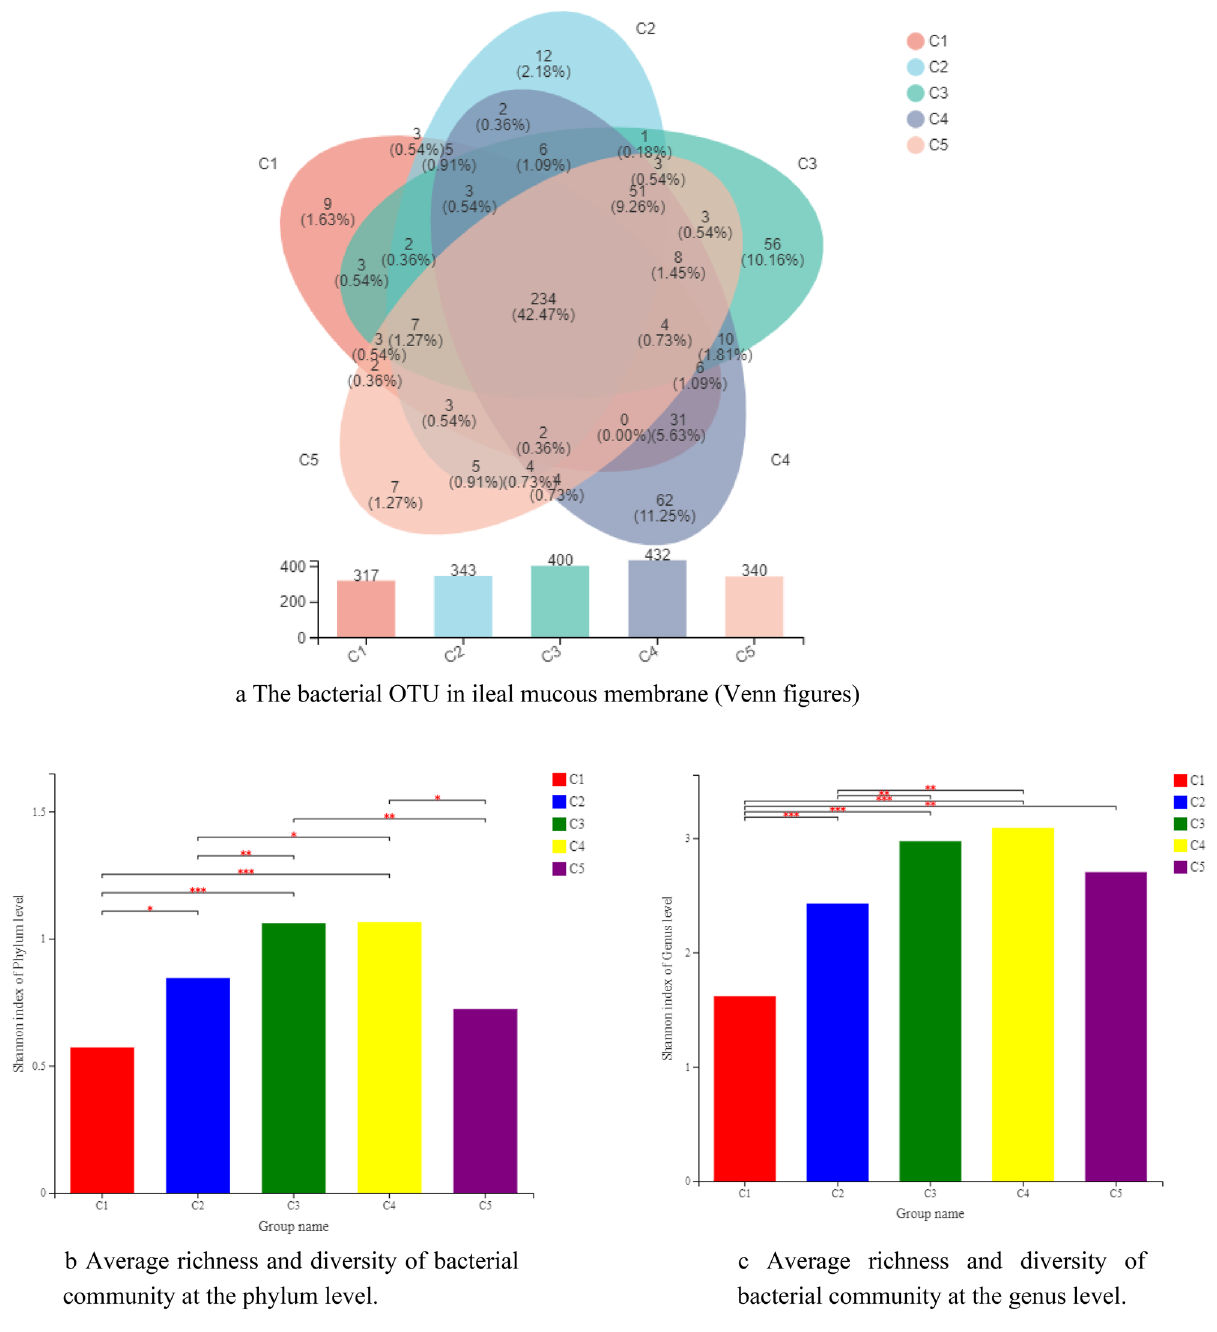
Figure 3. Overall profile of bacterial composition in ileal mucous membrane. ( a ) The bacterial OTU in ileal mucous membrane (Venn figures). The number in the color circus or overlapped circus represented the owned OTU in one or more groups and correlated proportion. ( b ) Bacterial composition at the phylum level. ( c ) Bacterial composition at the phylum genus level. *in the same column means P < 0.05, **P < 0.01, and ***P < 0.001. ( d , e ) PCoA analysis of UniFrac distance metric of bacterial OTUs at the genus level ( d ) and phylum level ( e ). Figure was drawn by the ANOSIM of UniFrac distance metric. ( f , g ) One-way ANOVA analysis of bacterial composition at the phylum level ( f ) and phylum genus level ( g ). * n the same column means P < 0.05, **P < 0.01, and ***P < 0.001. The Microsoft Office Excel 2010 was used to as the stamp